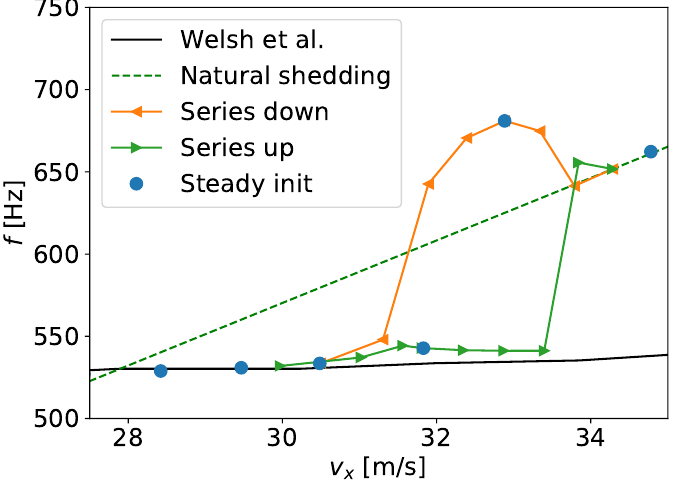
Figure 6. Vortex shedding frequency determined from numerical results when initialized by steady states, or by previous results of unsteady simulations for increasing and decreasing velocities com- paring with the experimental findings by Welsh et al.